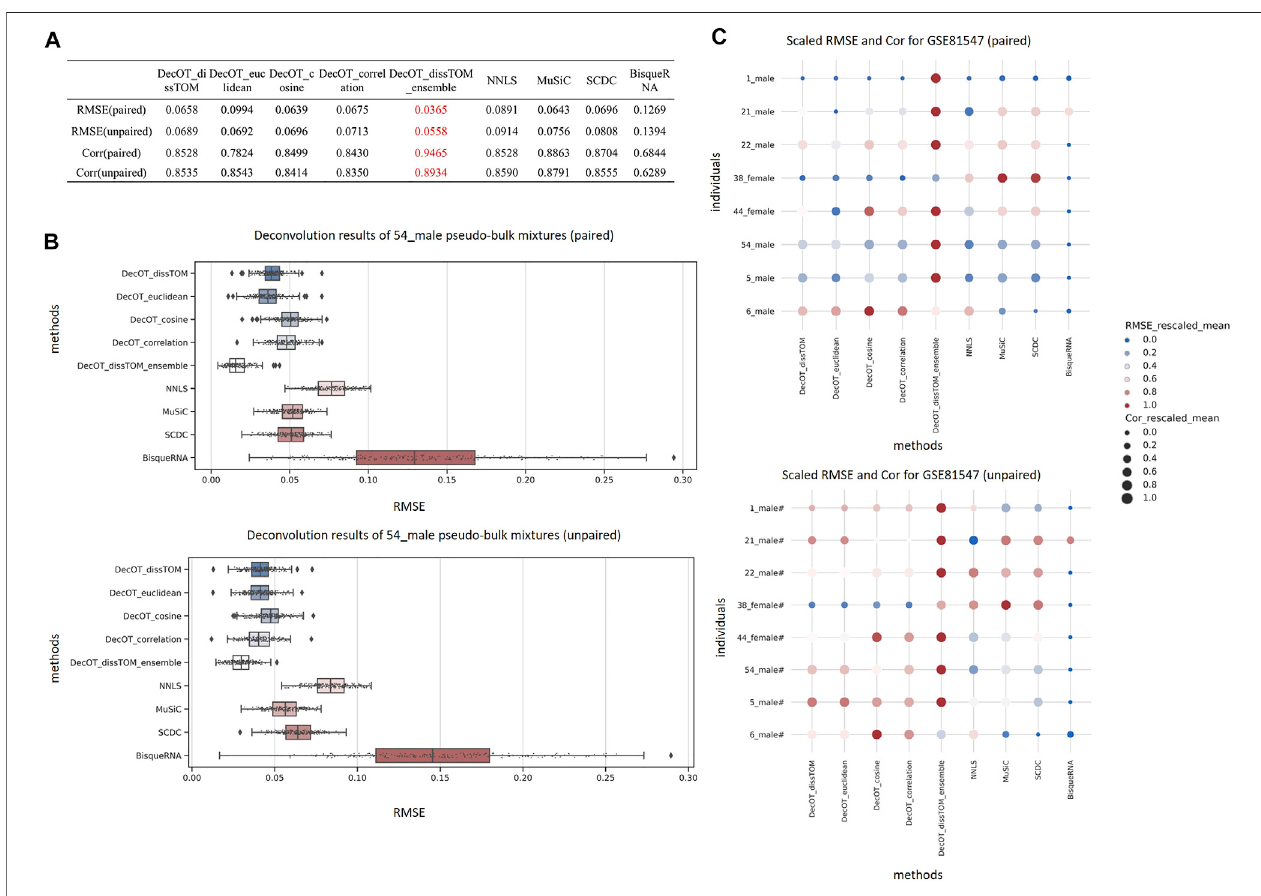
FIGURE 2| Benchmark results using data set GSE81547. (A) Average RMSE and Cor ofthe deconvolution results of all mixtures in data set GSE81547. From the overall results, the estimation of DecOT with the ensemble framework has smaller errors and stronger correlation than other methods. (B) Boxplot of RMSE from 200 replicatepseudo-bulk mixturesfromsample54_male.Thetop/bottompanelshowstheresultsunderpaired/unpairedsituation. (C) Overviewofdeconvolution resultsof individualpseudo-bulkmixturesacrossallmethodsindatasetGSE81547.Foreachindividual,weranktheresultsacrossdifferentmethodsandrescalethemtothe interval between 0 and 1. A darker-red and larger point within a line represents a smaller RMSE and a larger Cor. Both paired (top) and unpaired (bottom) situations are